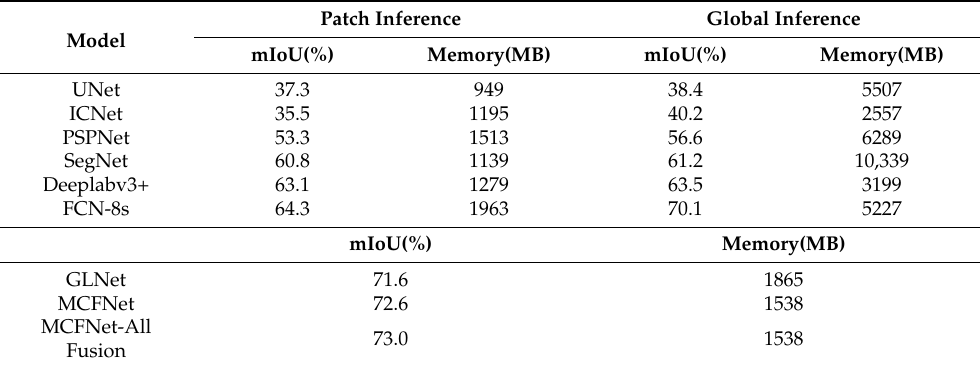
Table 2. Performance of MCFNet and other segmentation models on DeepGlobe